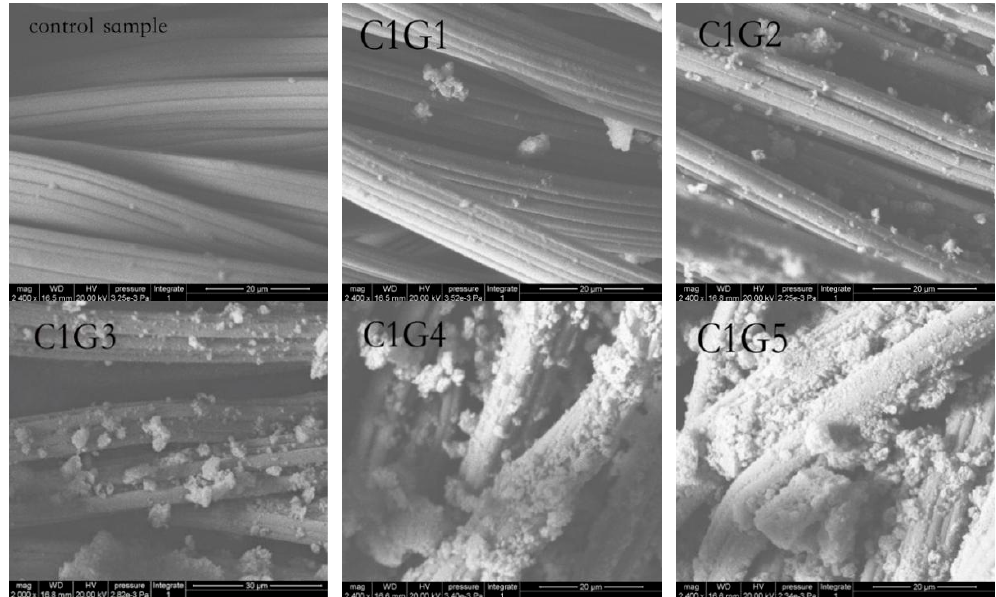
Figure 7. ESEM images of CS/Gr modified bamboo fiber fabrics (CGBFs).